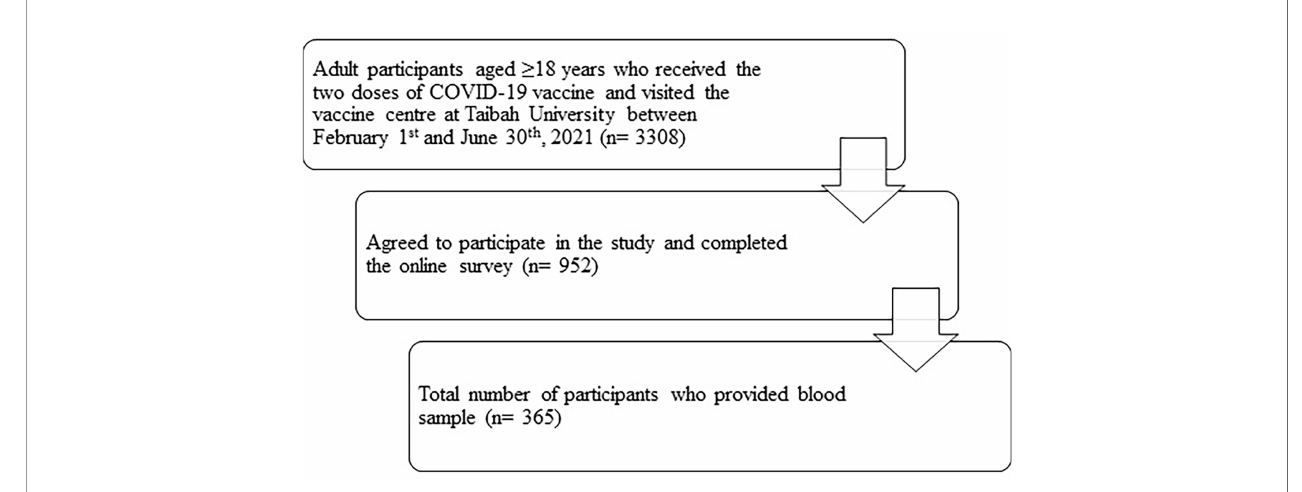
FIGURE 1 | Flowchart of patient